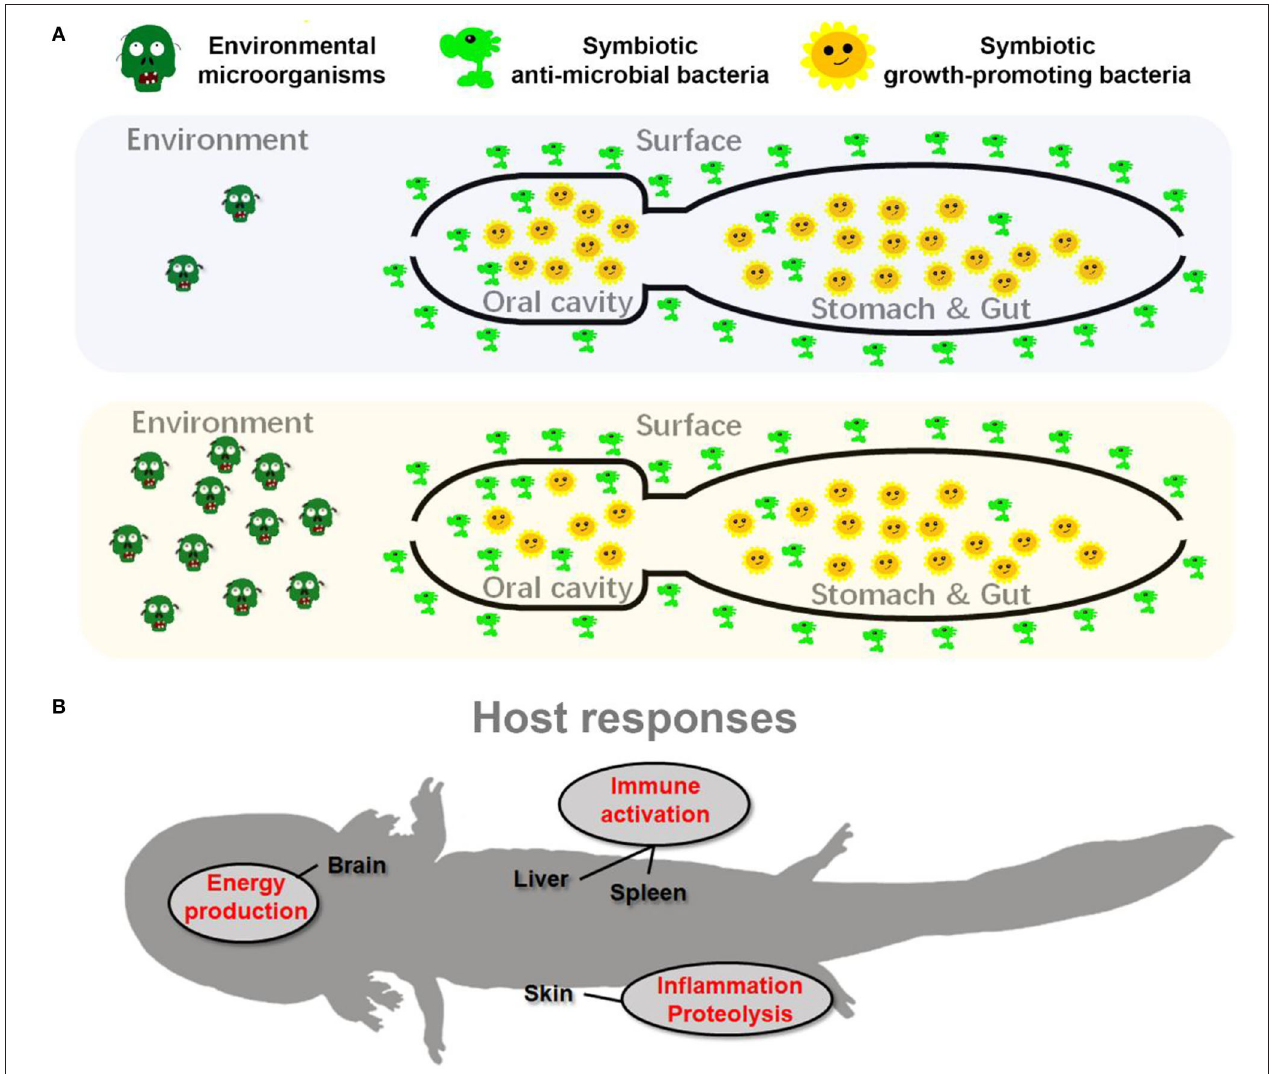
FIGURE 8 | Schematic diagram presents the adaptive adjustments of giant salamander to habitat river sediment acclimation. (A) The adjustments of symbiotic microflora; (B) the host transcriptional responses.